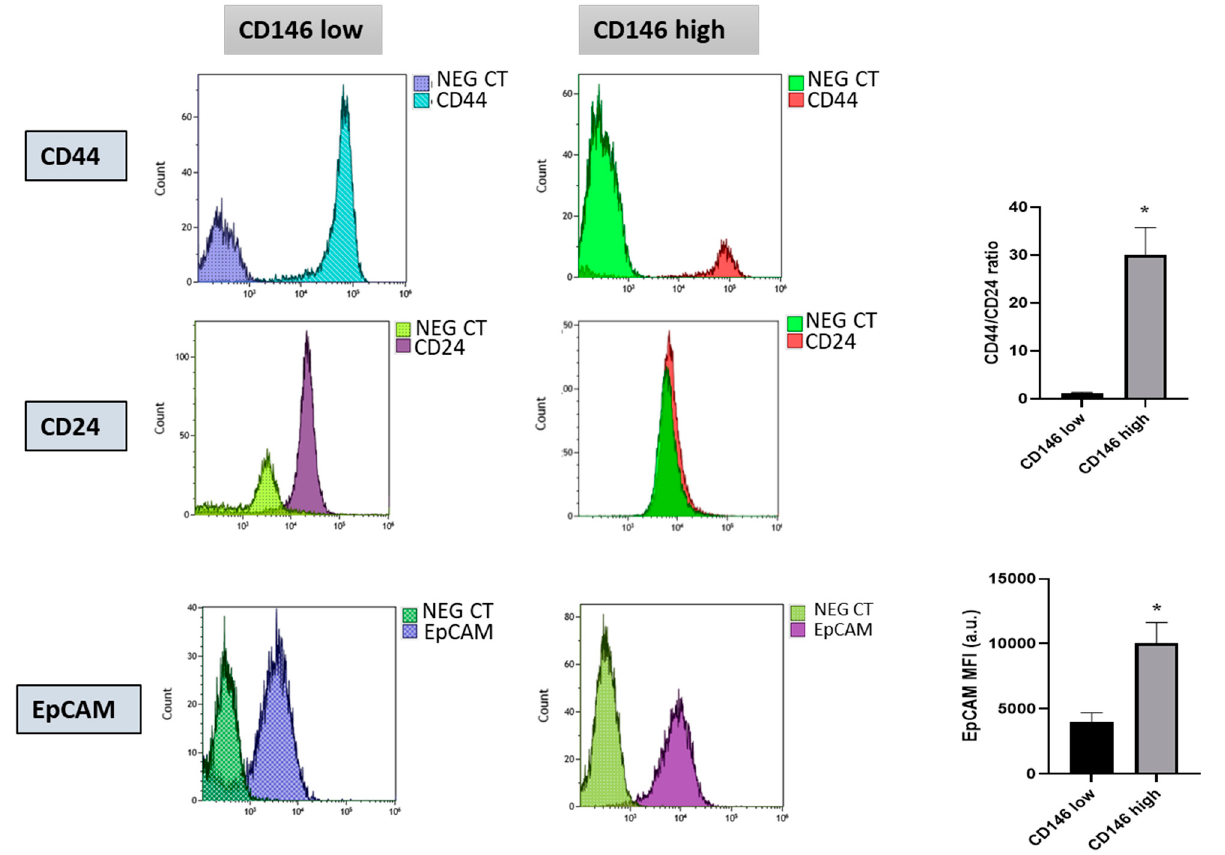
Figure 2. Characterization of CD146-low and CD146-high MDA-MB-231 cells for the expression of CSC markers. CD146-low and CD146-high MDA-MB-231 cells were characterized for the stem cells markers CD44, CD24 and EPcam by flow cytometry. Specific antibody and irrelevant negative control (NEG CT) were used. Representative experiments are shown. The average ratio of CD44/CD24 was calculated from the percentage of CD44 and CD24 positive subpopulations in the flow cytometry analysis from four different experiments. The average Mean Fluorescent Intensities (MFI) of EpCAM were determined in the two experimental conditions in four experiments. *: p < 0.05, CD146 high vs. CD146